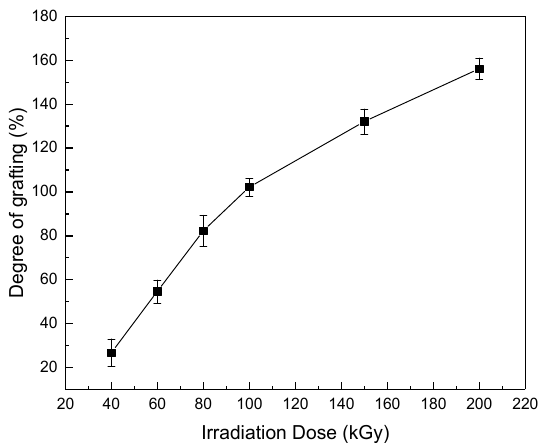
Figure 2. The effect of the absorbed dose of the PP sheets on the degree of grafting (AAm was grafted at 60 °C for 6 h in 30% aqueous solution).